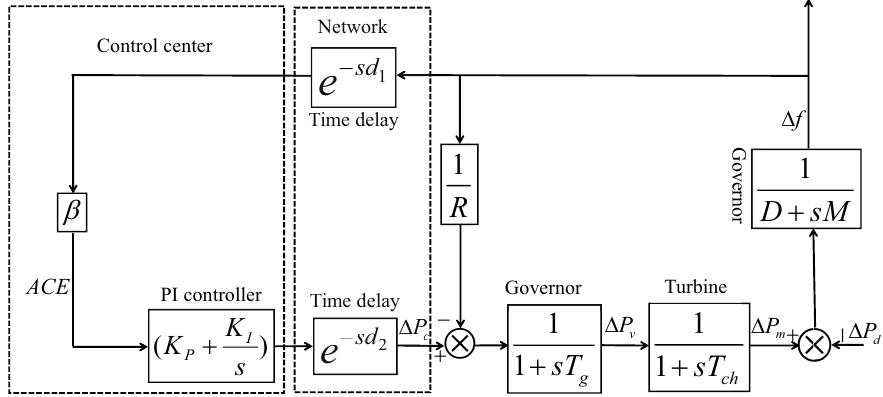
Figure 1. The basic diagram of the simplified LFC of one-area power